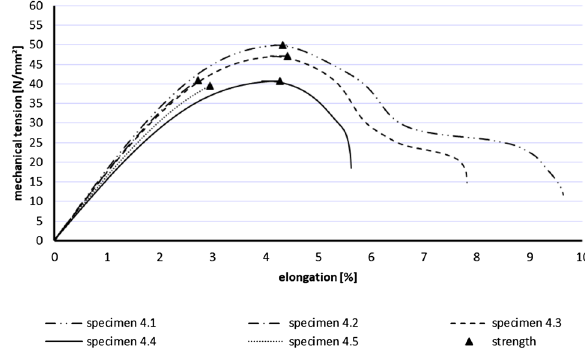
Fig. 17 Stress–strain diagram sample 4 (100% recycled pelletized material)